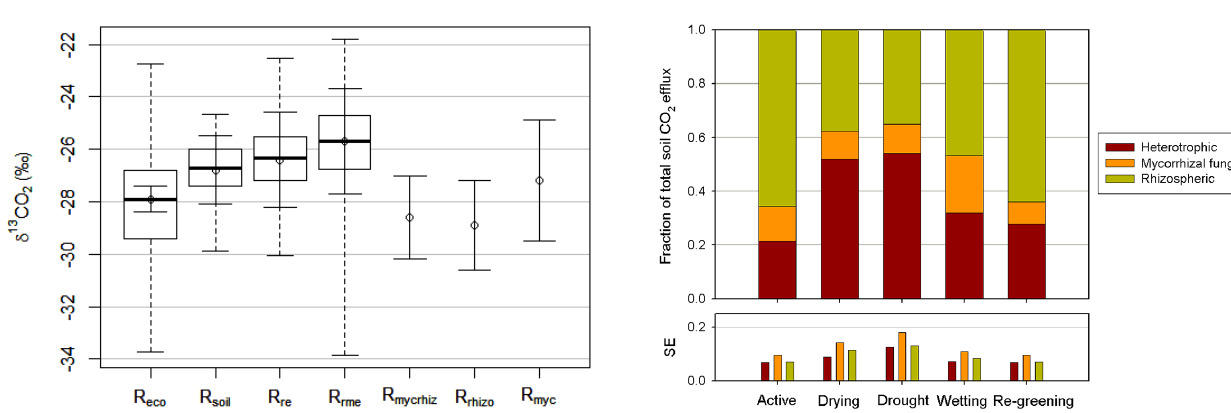
Figure 2. Measured ( R eco , R soil , R re , R rme ) and estimated ( R mycrhiz , R rhizo , R myc ) δ 13 C values of the respiration compo- nents. Horizontal black lines in boxes show medians and dashed whiskers show data extremes. Open circles and solid whiskers show mean ± propagated standard errors. Gray horizontal lines show y major values.